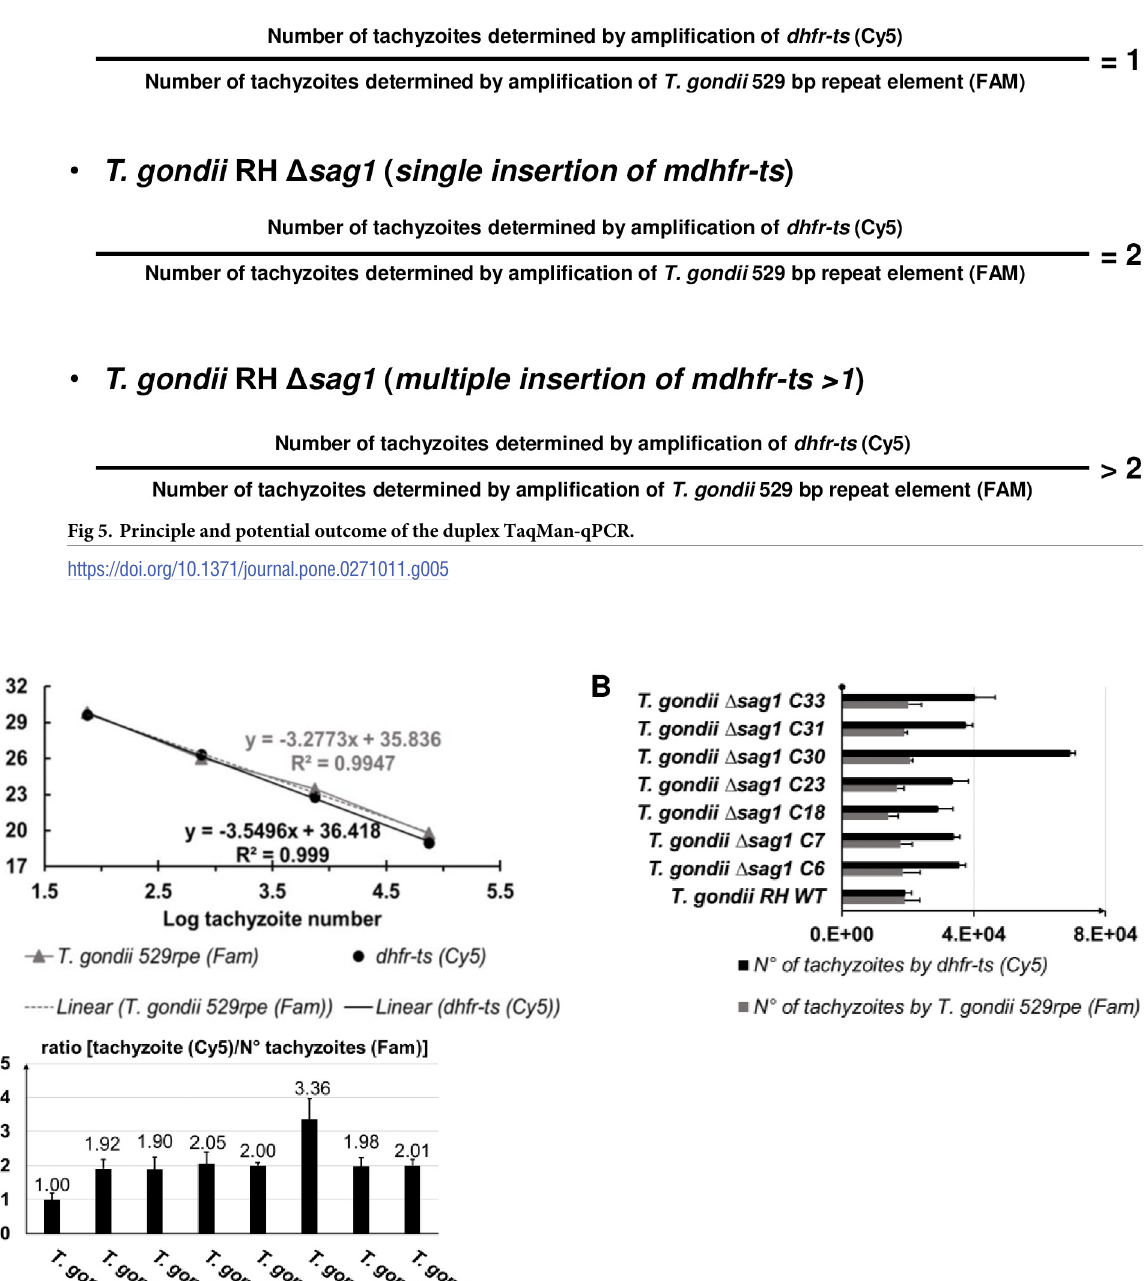
PLOS ONE | https://doi.org/10.1371/journal.pone.0271011 September 16,